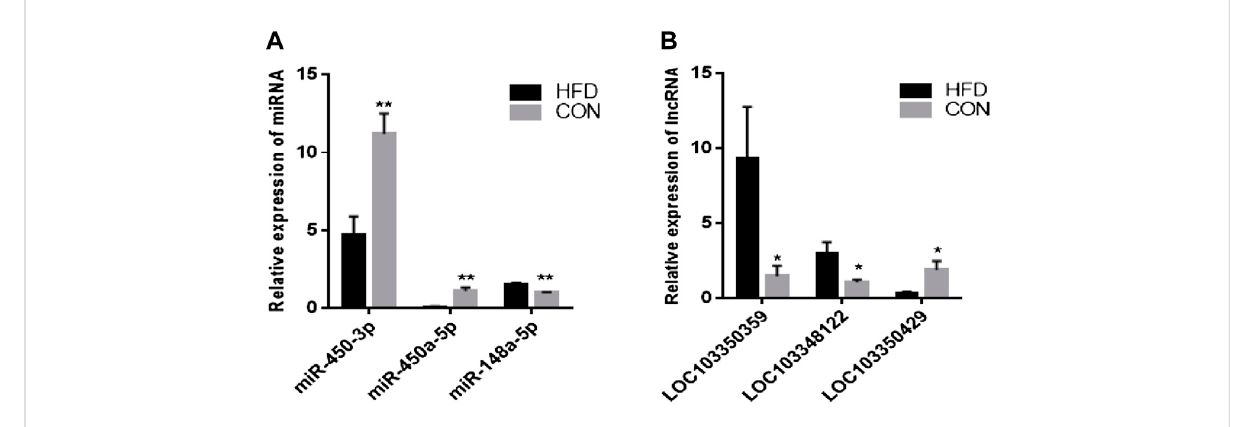
FIGURE 7 Validation of DE miRNAs and DE lncRNAs. The data are presented as means ± SEM. * p < 0.05; ** p <